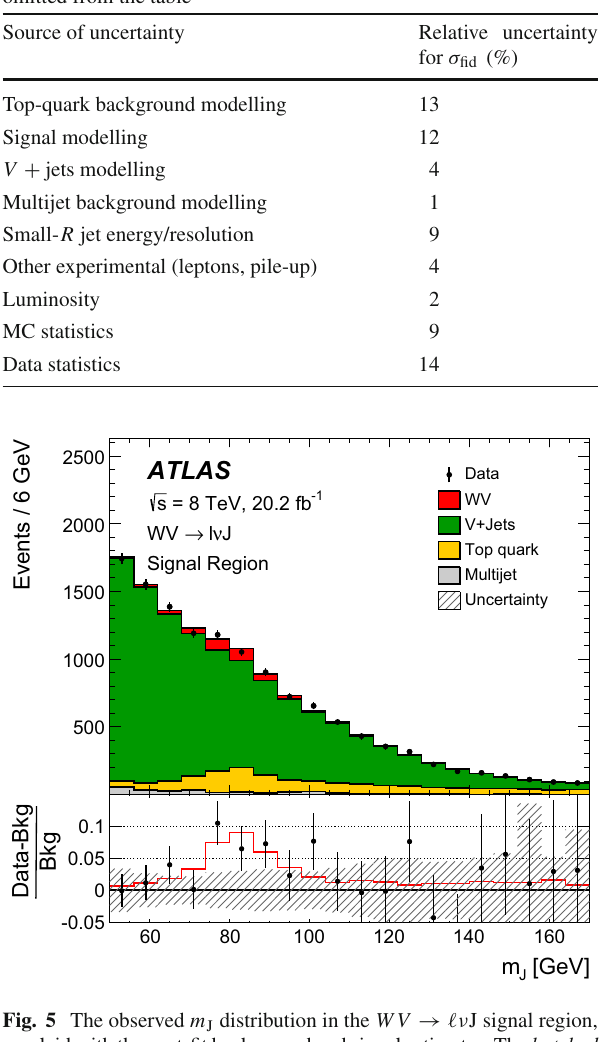
Table 3 Breakdown of the uncertainties in the measured fiducial cross- section in the WV → (cid:4)ν jj channel. Uncertainties smaller than 1% are